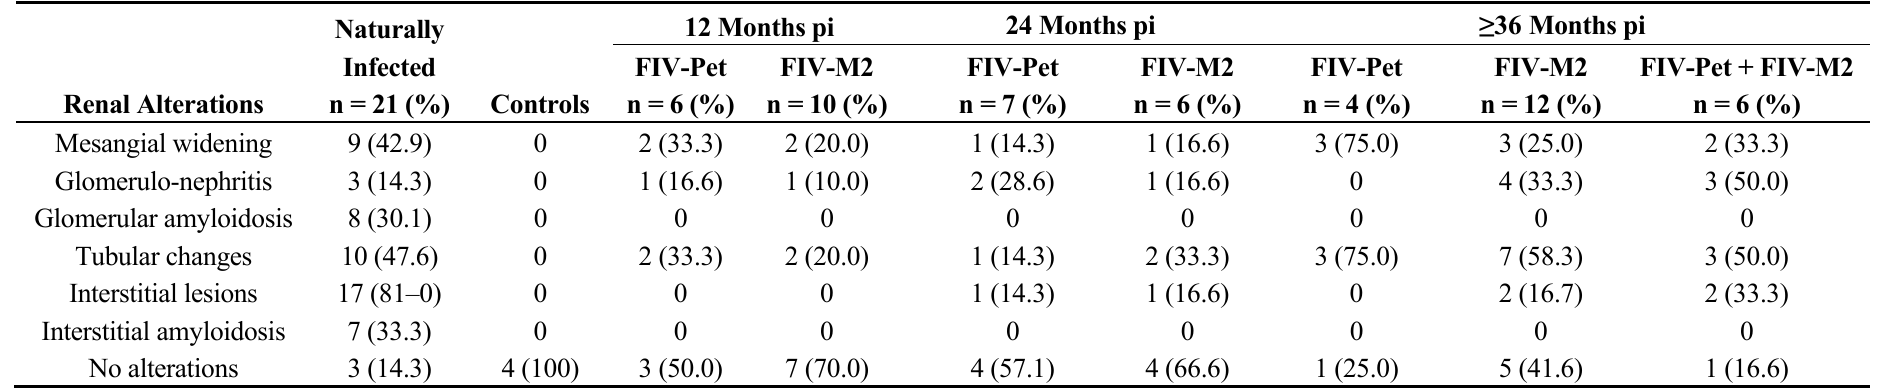
Table 2. Renal alterations detected in experimentally feline immunodeficiency virus (FIV)-infected cats sacrificed at the indicated times post-infection